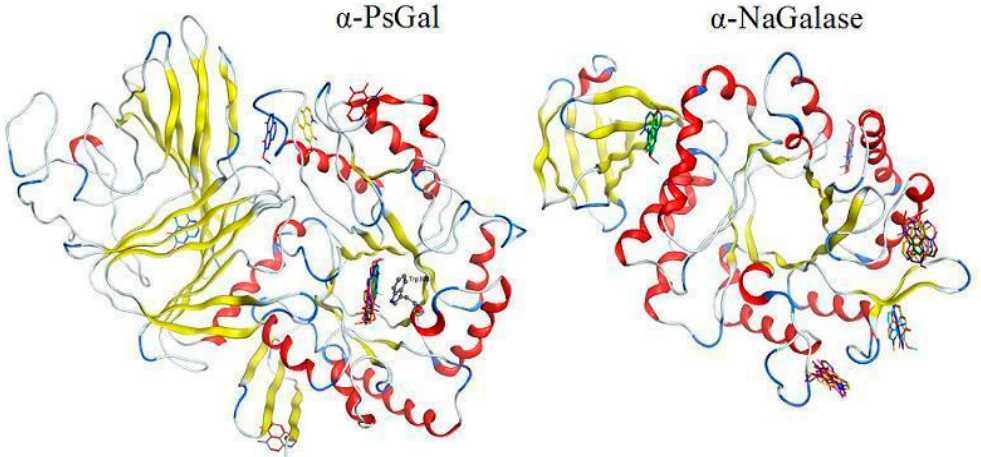
Figure 5. Superposition of the 20 most beneficial complexes of isoaaptamine with one subunit of bacterial α -D-galactosidase of GH36 family and human lysosomal α -NaGalase (Protein Data Bank: 3H54) of GH27 family. Protein structures are shown in ribbon diagrams, the isoaaptamine molecule is shown as sticks. The structures of the complexes were calculated using the GRAMM